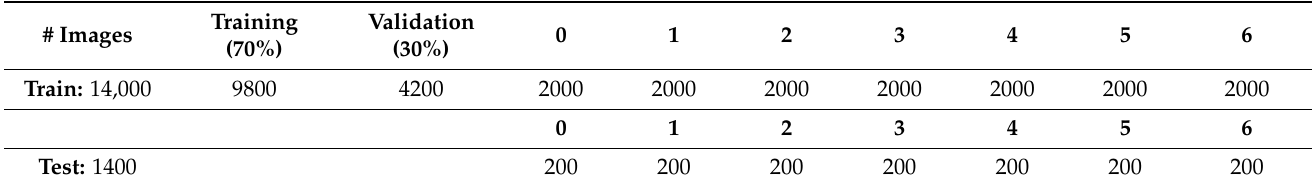
Figure 3. A customized DL model for counting insects that fits into a microprocessor. Table 1. The reference database. Numbers 0–6 denote how many insects are in an image.